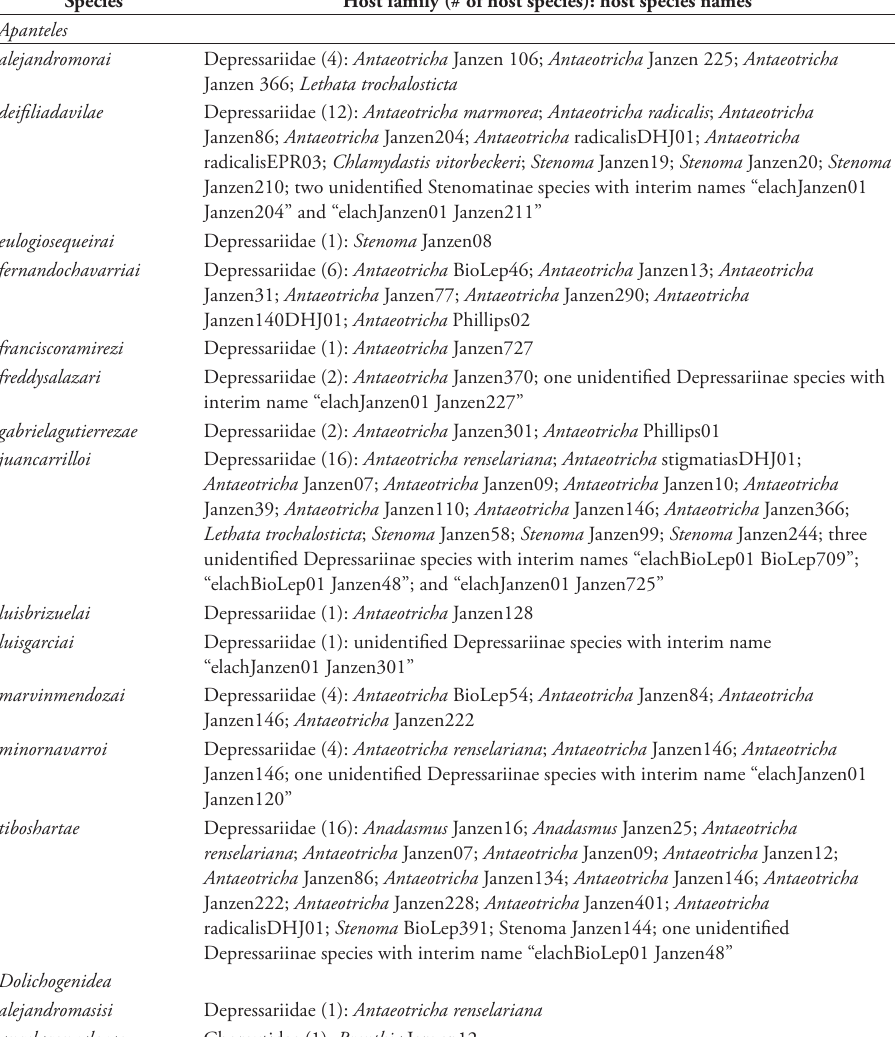
Table 1. Updated information on the hosts of the Apanteles alejandromorai and Dolichogenidea carlosma- nuelrodriguezi species groups in ACG, Costa Rica. For some host species only interim names are available at present. For an explanation on how those interim names are produced see Janzen & Hallwachs (2016) and also